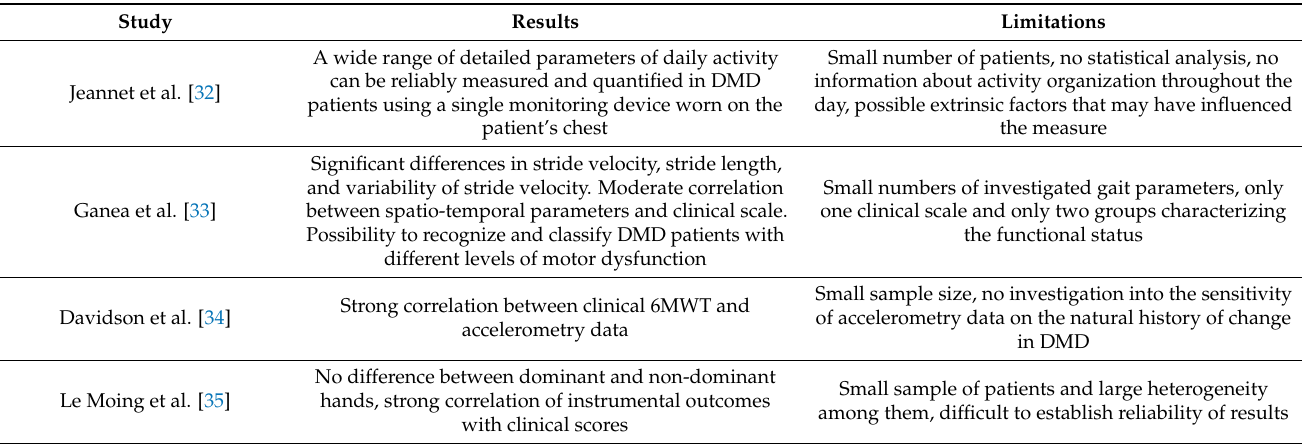
Table 3. Summary of main results and limitations of each